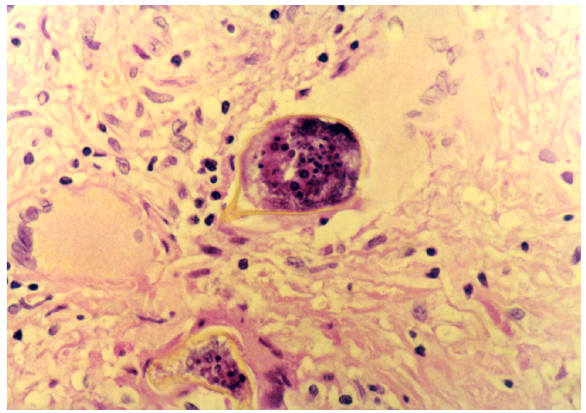
Figure 1 – Histology of the biopsy specimen, demonstrating the schistosomal egg (HE,